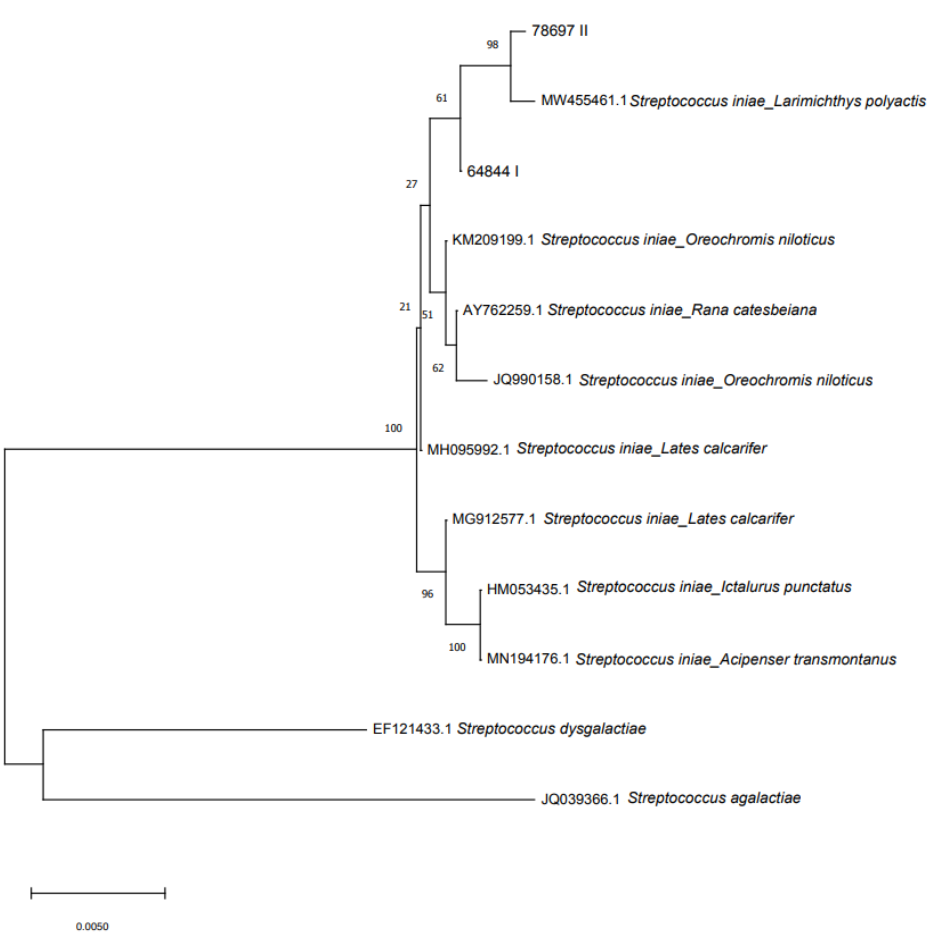
Figure 4. Phylogenetic relationship based on 16S rRNA gene sequences of S. iniae isolated from sturgeon with other NCBI reported sequences of Streptococcus . The phylogenetic tree was constructed